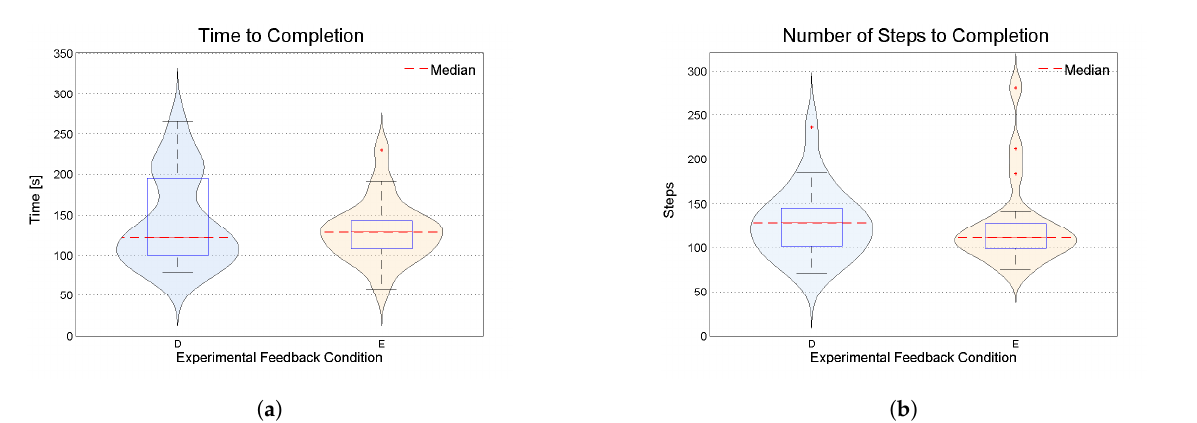
Figure 14. Performance comparisons between modes D and E for Experiment II, showing ( a ) distribution for time required and ( b ) number of steps needed to complete the navigation task.